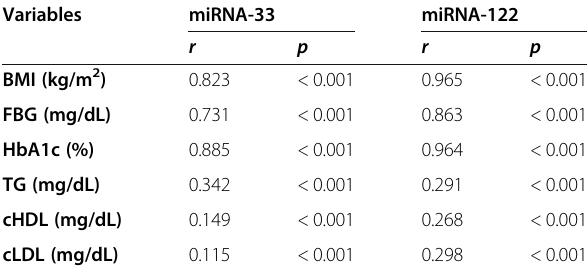
Table 2 Correlation of miR-33 and miR-122 with biochemical parameters in patients